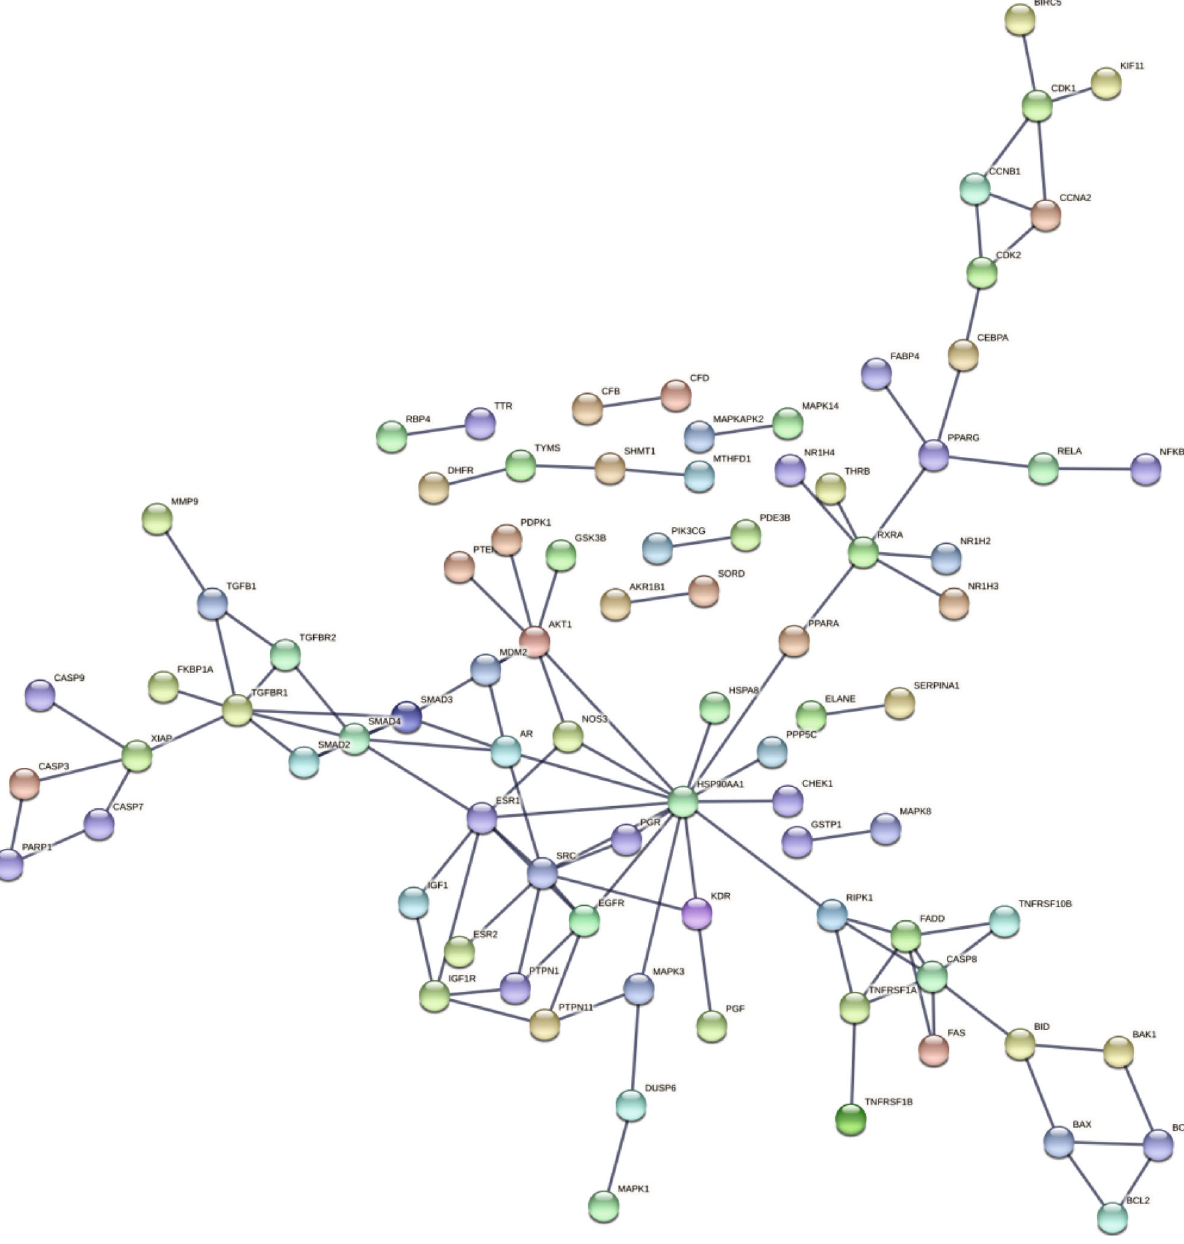
Figure 3: Protein interaction network of osthole and gastric cancer.